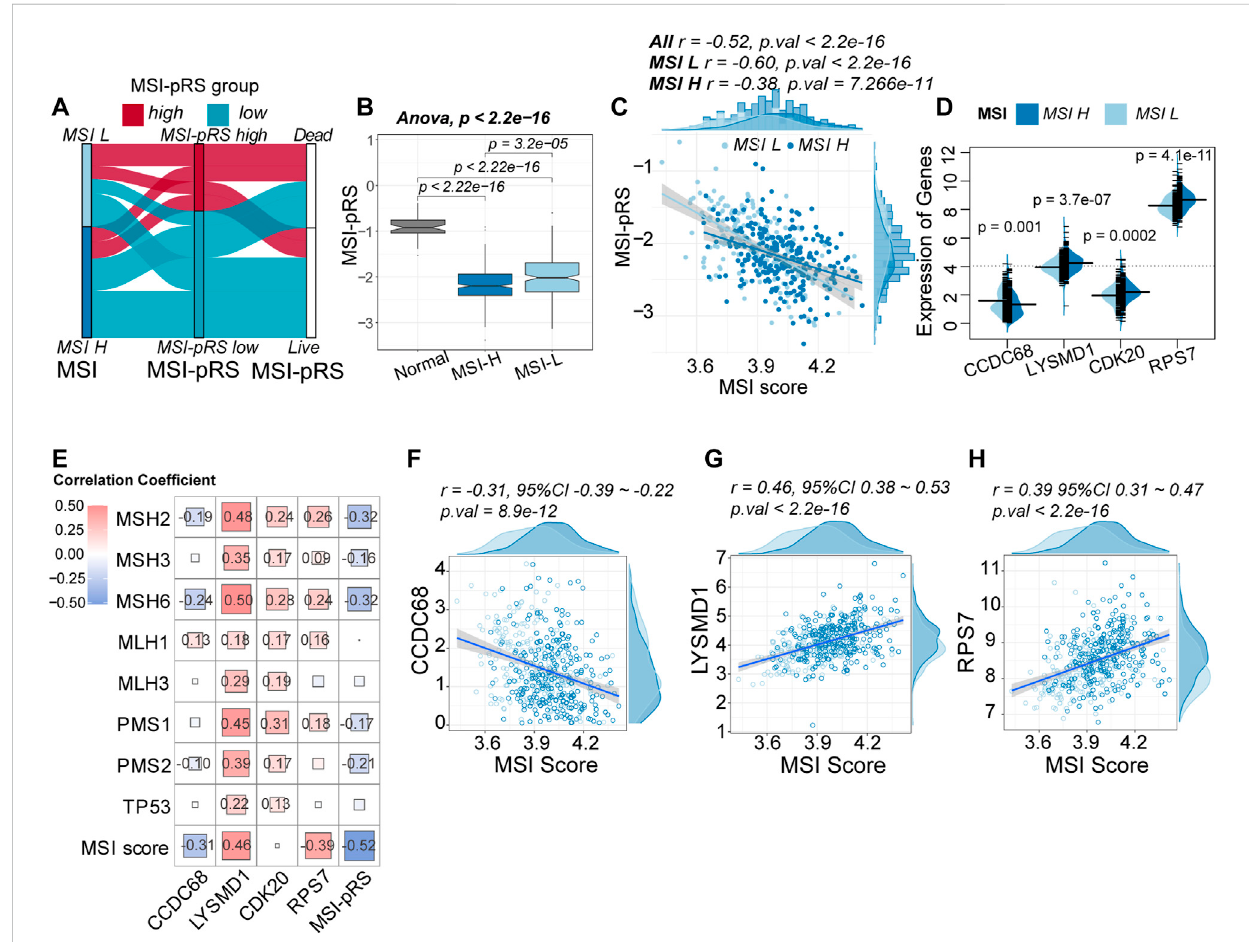
FIGURE 9 Relationship between the MSI-related prognostic risk score (MSI-pRS) and MSI status. (A) Flow diagram depicting the correlation among MSI status, MSI-pRS group, and clinical outcome in the TCGA LUSC training cohort. (B) Comparison of the MSI-pRS among normal samples, MSI-L samples, and MSI-H samples. MSI-pRS was decreased from the normal samples to the MSI-H samples (normal > MSI-L > MSI-H). (C) Correlation between MSI score and MSI-pRS. MSI-pRS was negatively correlated with MSI score. (D) Comparison of the four elements used to construct the MSI-pRS model between MSI-H and MSI-L groups. LYSMD1, CDK20, and RPS7 were higher in the MSI-H group, while CCDC68 was higher in the MSI-L group. (E) Relationship between MMR systems and MSI-pRS. (F) Correlation of CCDC68 and MSI scores. (G) Correlation of LYSMD1 and MSI scores. (H) Correlation of RPS7 and MSI